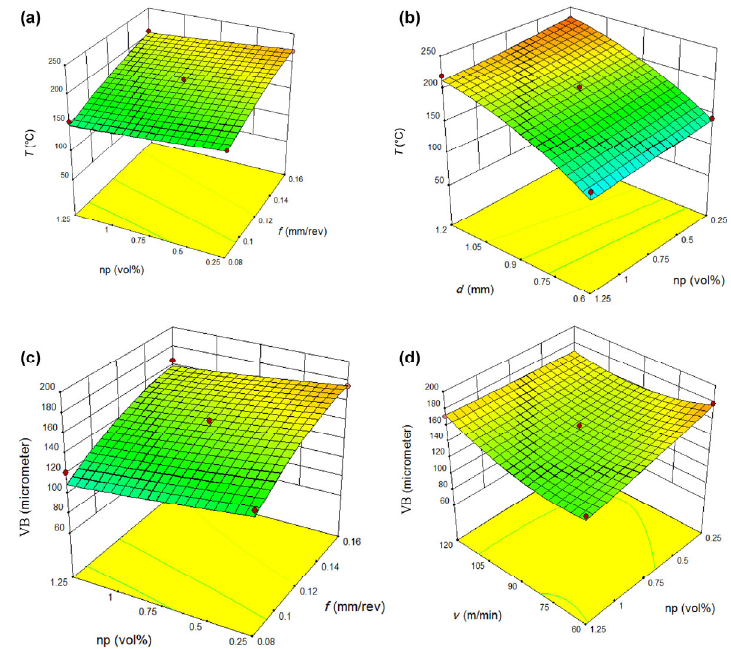
Fig. 11 Estimated response surface plots for Al 2 O 3 nanoparticle concentration (np) versus v , f , and d.